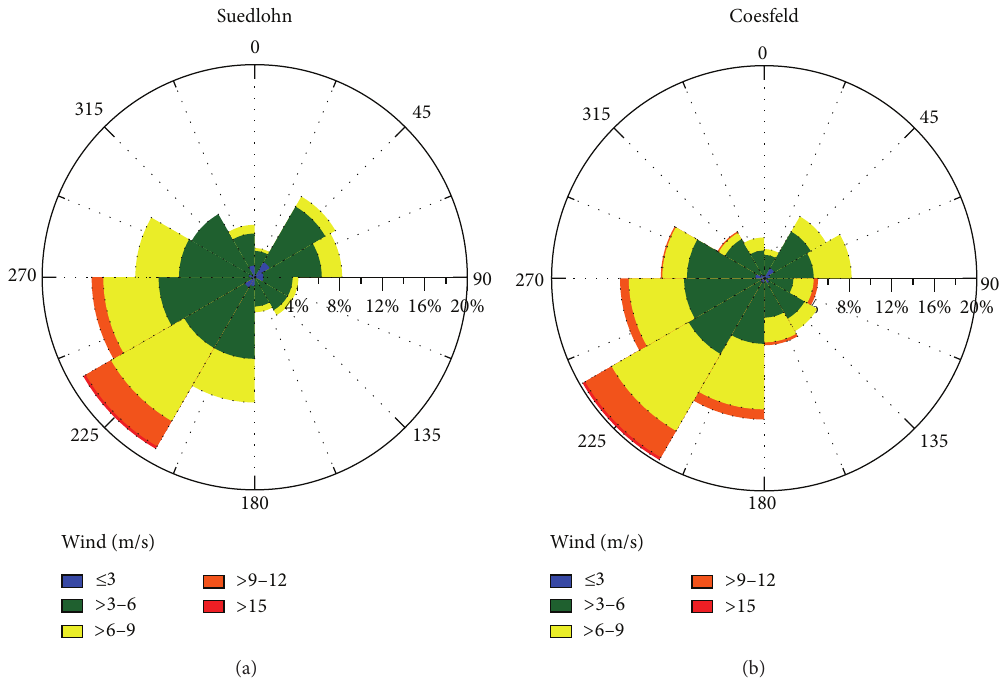
Figure 6: Average wind conditions at the locations Suedlohn (target site) and Coesfeld (input site) during the data collection period from January 2006 to January 2008.